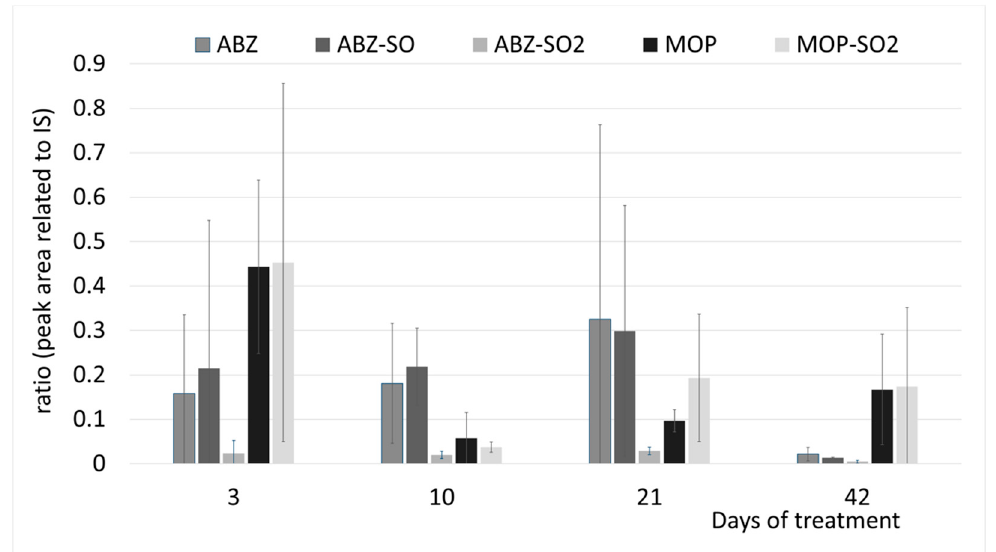
Figure 4. Semi-quantification expressed as peak area related to internal standard (IS) of albendazole (ABZ), albendazole sulfoxide (ABZ-SO), and albendazole sulfone (ABZ-SO 2 ); or monepantel (MOP), and monepantel sulfone (MOP-SO 2 ) in T. pratense shoots. The graph shows changes in relative concentrations of the compounds after a single application of faeces containing ABZ, ABZ-SO, ABZ-SO 2 or faeces containing MOP and MOP-SO 2 compared to control samples at day 3, 10, 21, 42. The data are expressed as mean ± SD, n = 3. Control samples did not contain ABZ, ABZ-SO, ABZ-SO 2 , MOP, or MOP-SO 2 .